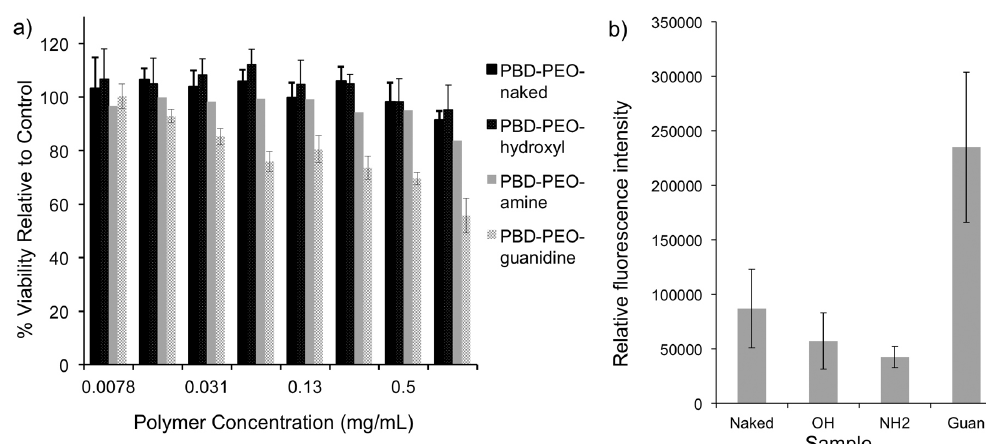
FIGURE 9 - a) Toxicity of naked and dendron functionalized PBD-PEO polymersomes as measured by an MTT assay following 48 hour of incubation with HeLa cells; b) Quantitative comparison of the uptake of naked and dendritic hydroxyl, amine, and guanidine functionalized polymersomes in HeLa cells following a 1 h incubation at 37 °C, as measured by fluorescence confocal